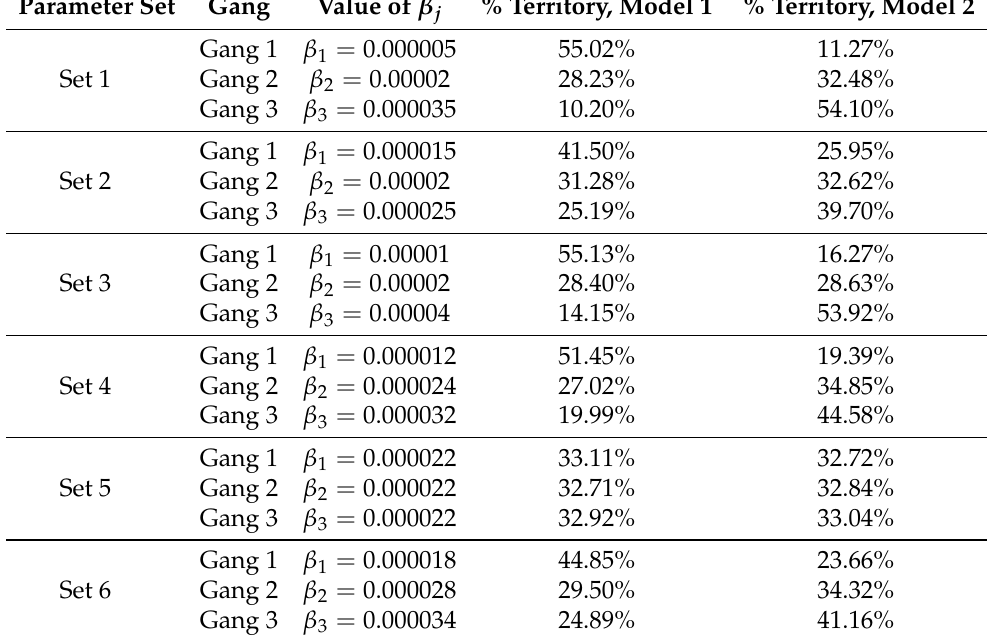
Table 1. Here, we see the results of both variations of the original model for six different sets of β j in three-gang simulations. Here, Model 1 refers to the Timidity Model variation, while Model 2 refers to the Threat Level Model variation. The β j values are listed, along with the percentage of the lattice dominated by each gang at equilibrium. Note that the percentages do not add to 100% because in each simulation, a small percentage of the lattice is not clearly dominated by any one of the